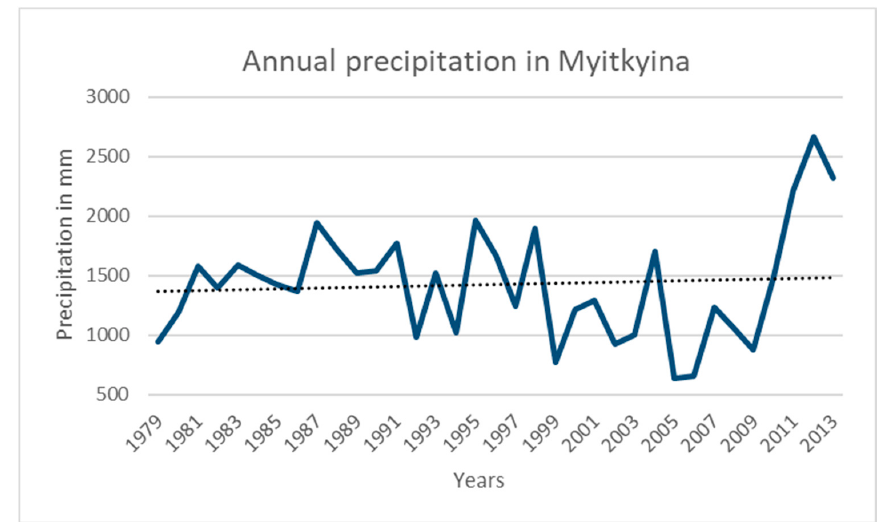
Figure 7. Annual precipitation at the Myitkyina meteorological station, located in the upper Ayeyarwady basin (see Figure 1), with a linear trend. Table 6. Mean annual absolute losses in water equivalent (WE) for the sub-regions. Water Equivalent/a (m)